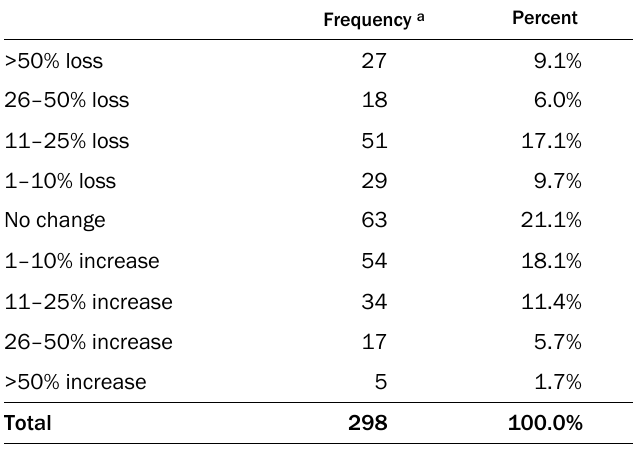
Table 1. Farmer-Estimated Change of Revenue in 2020 Due to the COVID-19 Pandemic